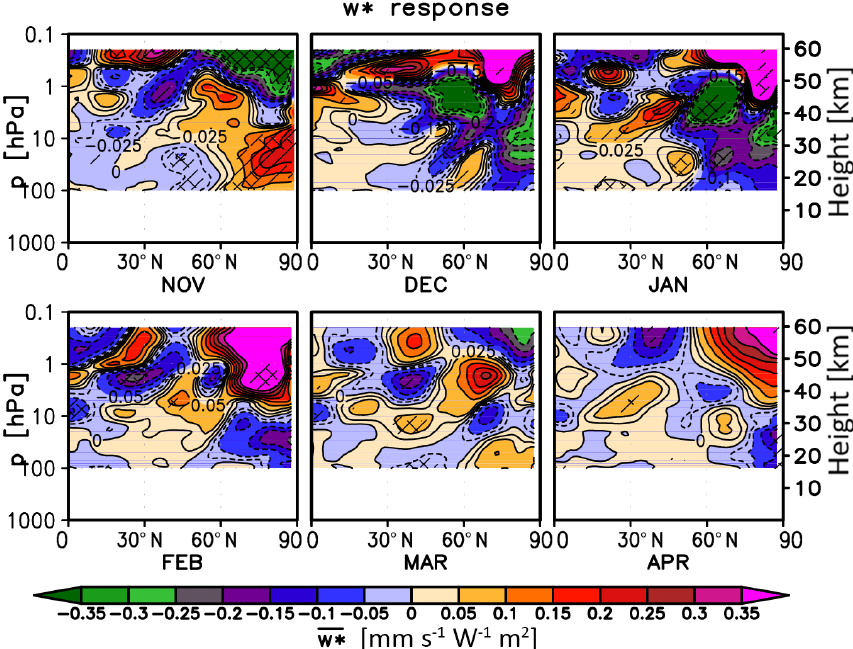
Figure 9. As in Fig. 8 but for the transformed vertical component of the residual circulation ( w ∗ ; see Andrews et al., 1987) response (mms − 1 W − 1 m 2 ) in UM-UKCA. Positive values indicate upwelling. Note the additional contours at ± 0 . 025mms − 1 W − 1 m 2